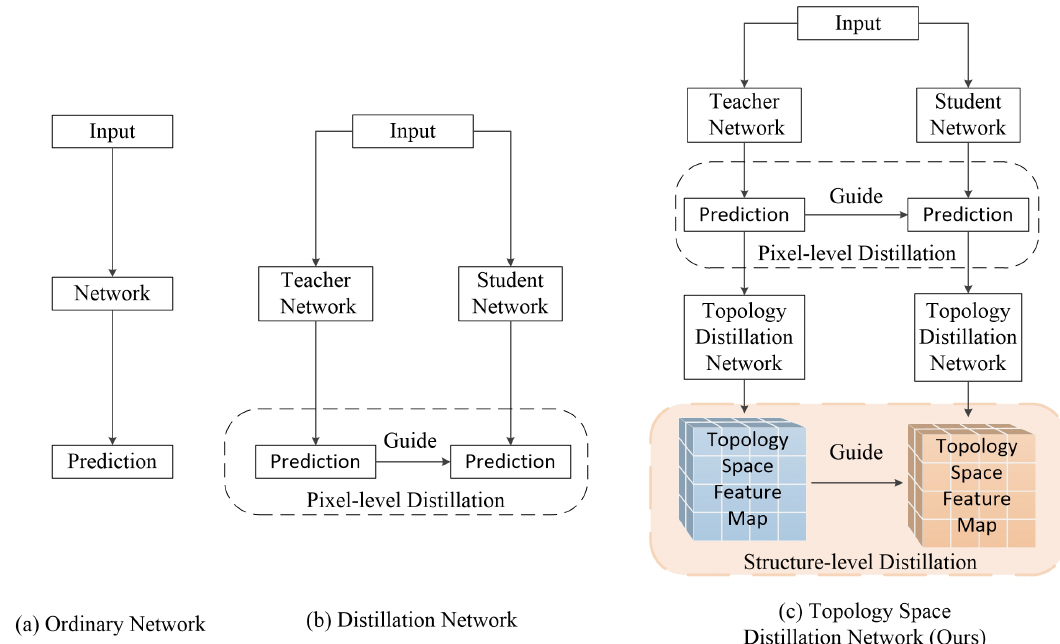
Figure 2. An illustration of the distillation pipeline. ( a ) Ordinary network: this is the familiar deep learning process. ( b ) Distillation Network: the classic knowledge distillation process in which the pixel-level feature can be transformed from the teacher net to student net. ( c ) Topological Space Distillation Network: this is our proposed strategy of knowledge distillation. It distills two kinds of knowledge: one is the pixel-level feature, and another is the structure-level